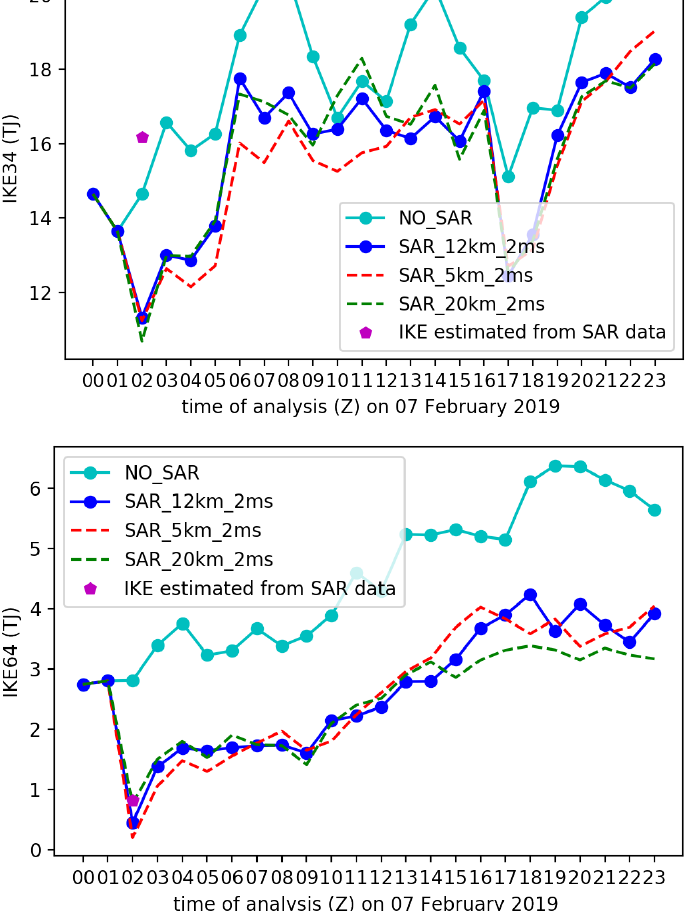
Figure 15. Evolution of IKE34 and IKE64 in the analyses of 7 February 2019 for